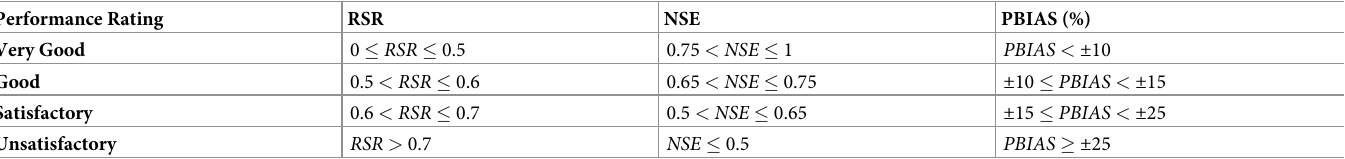
Table 3. Performance ratings of recommended statistics for streamflow simulations e.g Moriasi et al